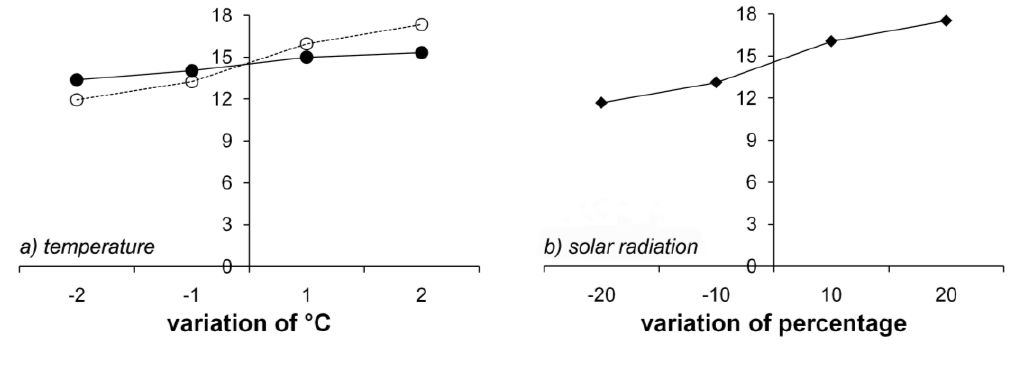
Figure 9. Effect of meteorological data on GPP as following (a) minimum temperature (open circle and dashed line) and maximum temperature (solid circle and solid line); (b) solar radiation The parameter values were changed −20%, −10%, +10%, and +20%, except for temperature, which was changed in degrees Celsius (−2 °C, −1 °C, +1 °C, and +2